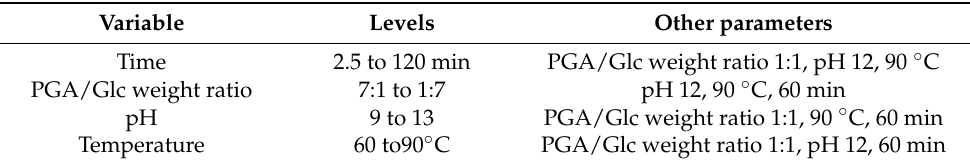
Table 1. Reaction conditions of PGA and Glc.